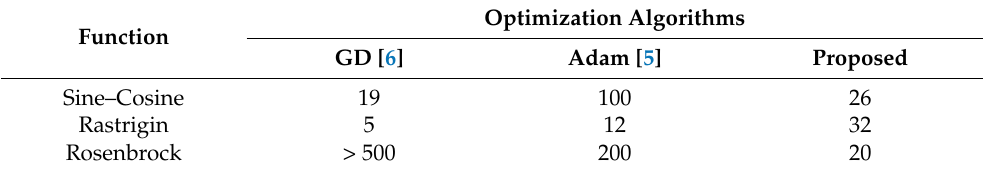
Table 2. Number of iterations by various algorithms.